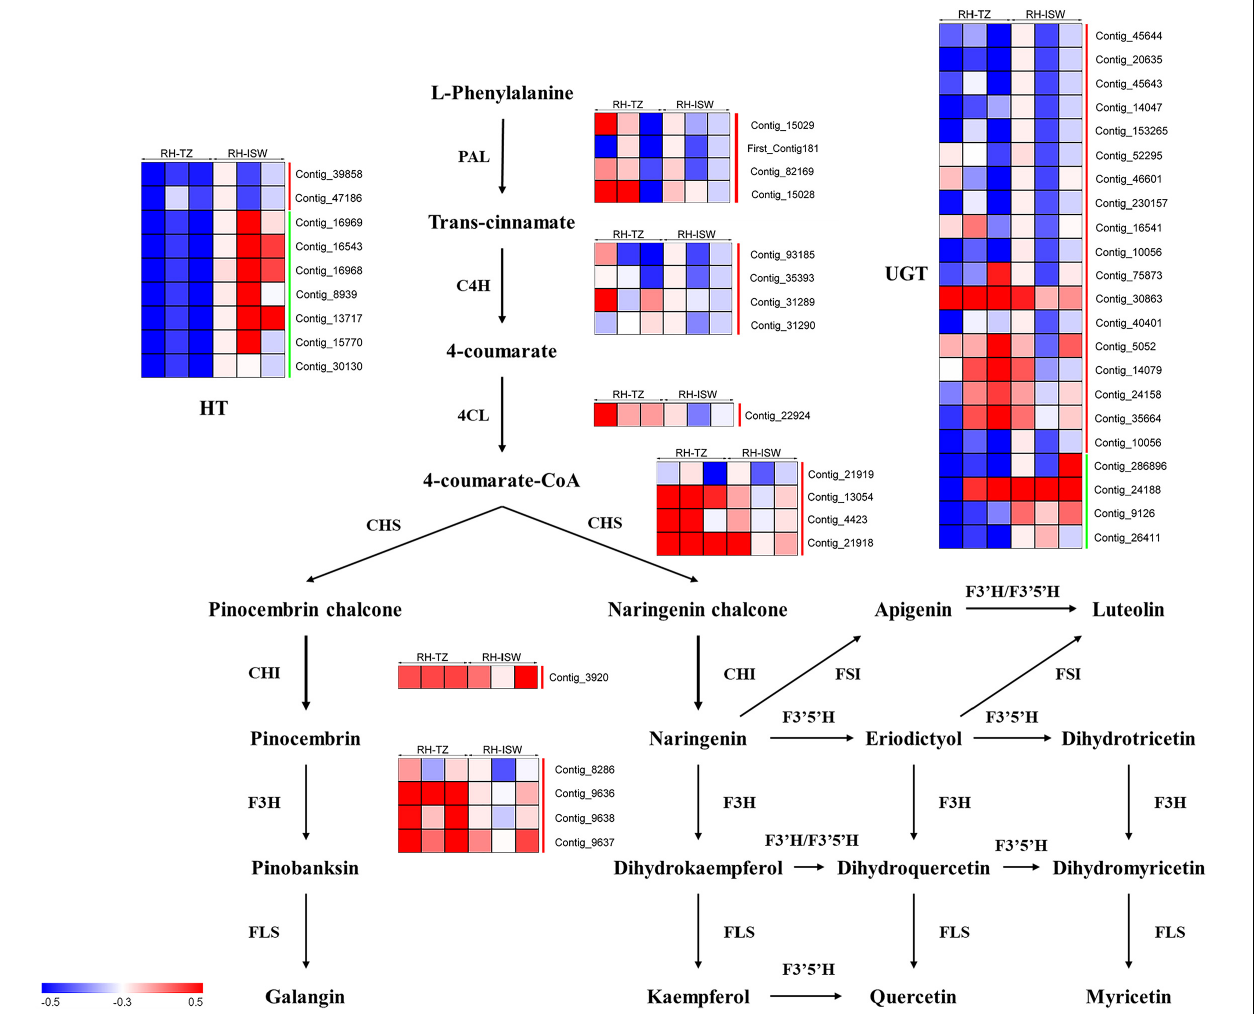
FIGURE 10 | Transcript profiling of genes in the phenylpropanoid and flavonoids biosynthetic pathways in RH-TZ vs. RH-ISW of red-heart Chinese fir. RH, red-heart Chinese fir; TZ, transition zone; ISW, Inner Sapwood; PAL, phenylalanine ammonia-lyase; C4H, cinnamic acid 4-hydroxylase; 4CL, 4-coumarate CoA ligase; CHS, chalone synthase; CHI, chalcone isomerase; F3H, flavanone 3-hydroxylase; FLS, flavonol synthase; F3 (cid:48) H, flavanoe 3 (cid:48) -hydroxylase; F3 (cid:48) 5 (cid:48) H, flavonoid 3 (cid:48) 5 (cid:48) -hydroxylase; FSI, flavone synthase I. The green line on the right side of the heatmap represented downregulation while the red line represented upregulation.